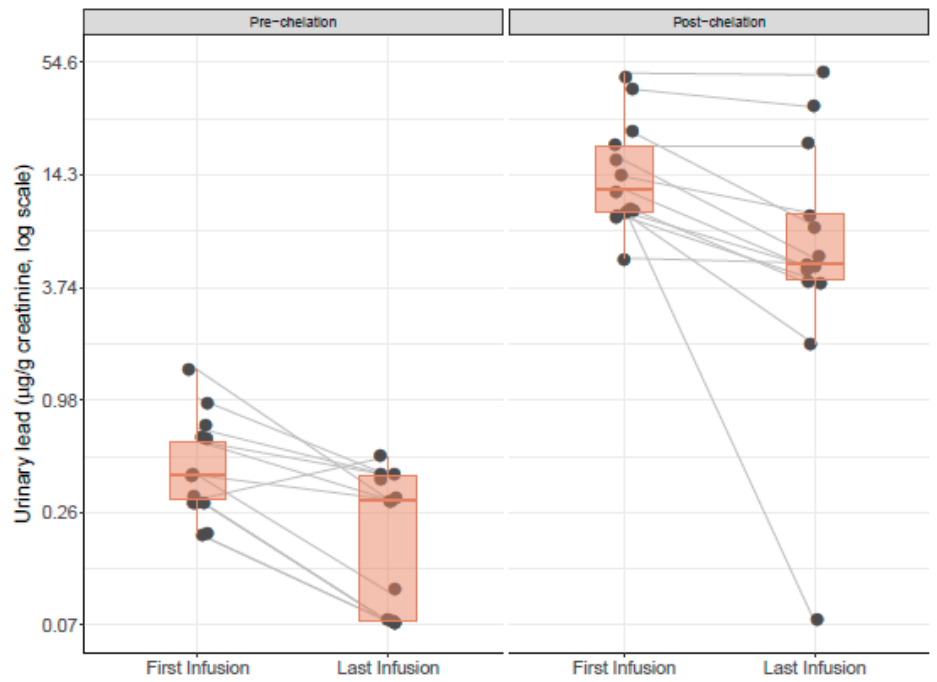
Figure 3. Within-person change in urinary lead concentrations ( µ g / g of creatinine) comparing the first and last infusion visits. Results are presented separately for urinary lead concentrations measured pre versus post edetate chelation. All values are controlled for creatinine concentration. Each black dot (jittered) represents an individual patient measurement. Gray lines connect measurements from individual patients and indicate a within-person change in the urinary lead concentrations. Boxplot upper, middle, and lower hinges correspond to the 25th, 50th, and 75th percentiles, respectively. The left panel compares the within-person change in the urinary lead concentrations in urine samples collected pre edetate chelation, comparing the first (baseline) and last infusion visits. The right panel compares the within-person change in the urinary lead concentrations in urine samples collected post edetate chelation, comparing the first (baseline) and last infusion visits. Orange horizontal bars represent the median values.